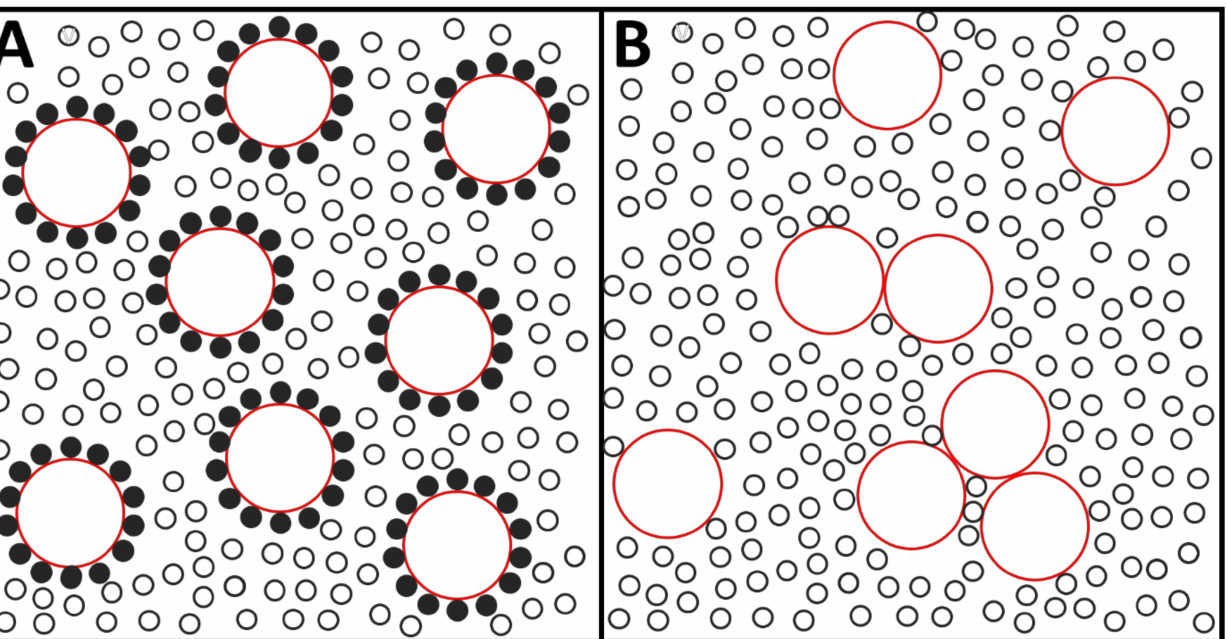
Figure 1. An outline of two views of protein-lipid interactions. ( A ), the annulus view. ( B ), the random distribution view. Circles in red: proteins. Black circles: lipids. Filled black circles: “annular lipids”. Entropic factors clearly favor the disposition in ( B ). The figure is extremely simplified. Note, in particular, the unnatural smooth perimeter of the proteins. Total lipid:protein ratio, 32:1. (Original from Dr. J. Sot).